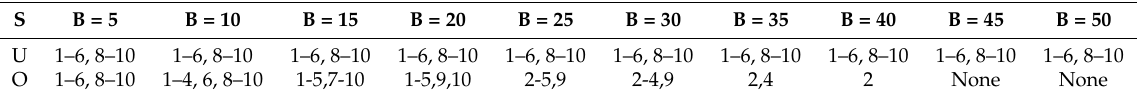
Table 6. The table shows indices of the nonvisited CH robots depending on battery capacity of UAV in Figure 7. “None” implies that the UAV visits all CH robots if B = 45 or B = 50. Strategy, UAV-oriented Strategy and optimal strategy are denoted by S, U and O, respectively, in this table.